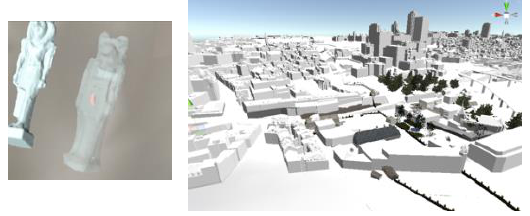
Figure 4. Egyptian amulets discovered at the intendant’s palace archaeological site, showing a lead inclusion revealed by CT scan analysis (left). 3D model of the modern city of Quebec